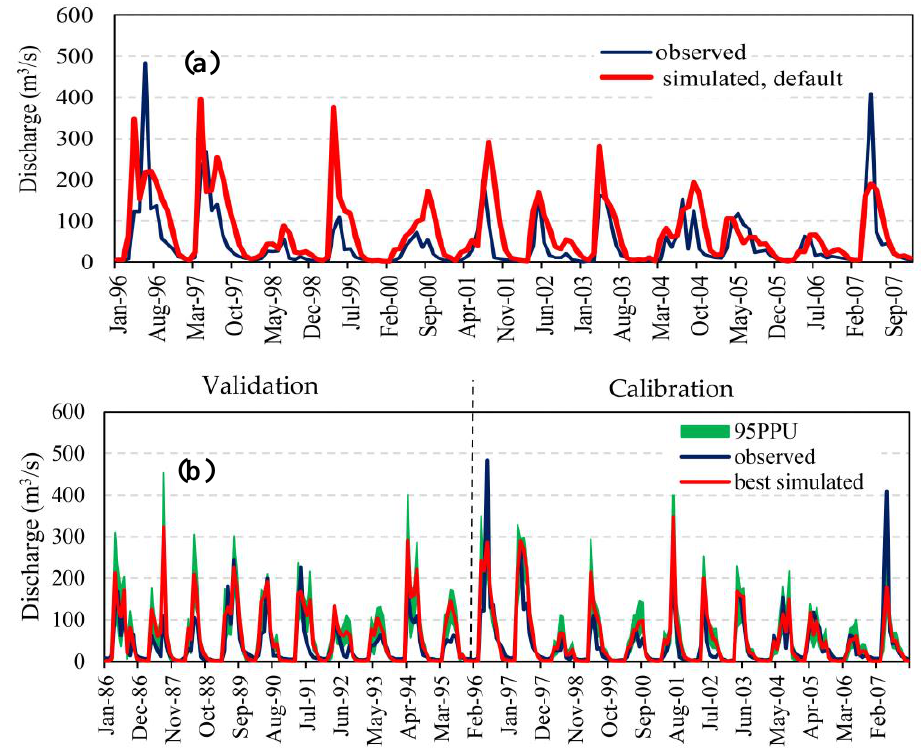
Figure 5. Comparison of the monthly simulated (green band) vs. observed (blue signal) streamflow for the Outlet Gauge in the Little Smoky River Watershed over the entire historical simulation period. ( a ) displays a simulation with the default basin parameters, and ( b ) shows the calibration and validation results.